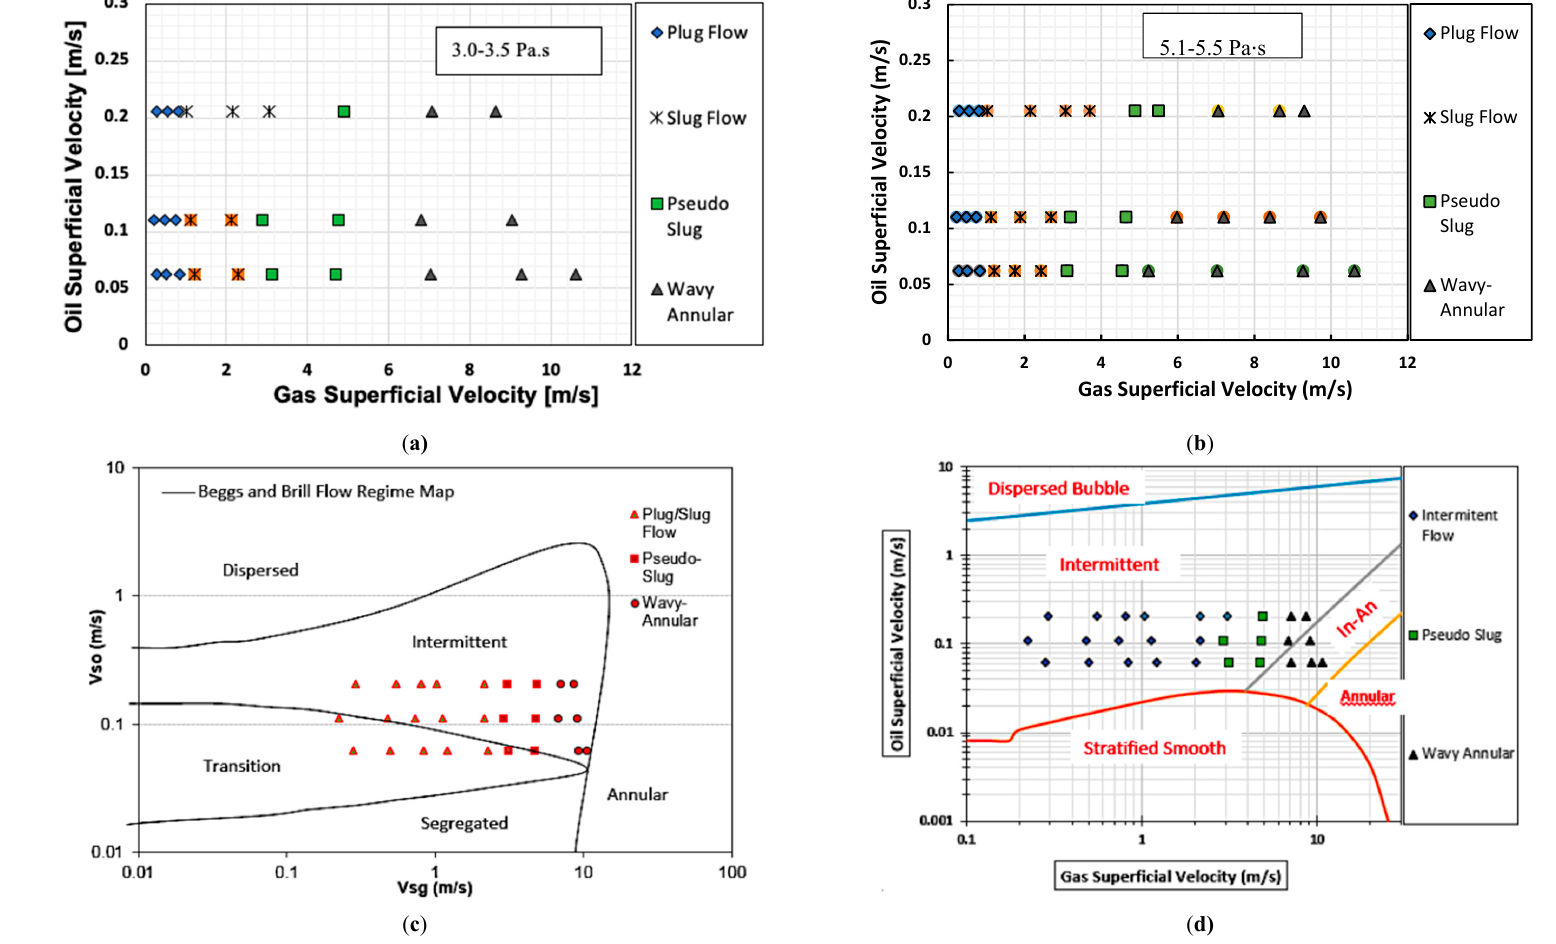
Figure 5. Experimental data points for ( a ) 3–3.5 Pa·s and ( b ) 5.5–5.5 Pa·s ( c ) plotted against the Beggs and Brill [35] flow pattern pap for gas-Liquid horizontal flow, shown in ( c ). A comparison of the observed flow patterns with the flow pattern map of Taitel and Dukler [36] is given in ( d ).